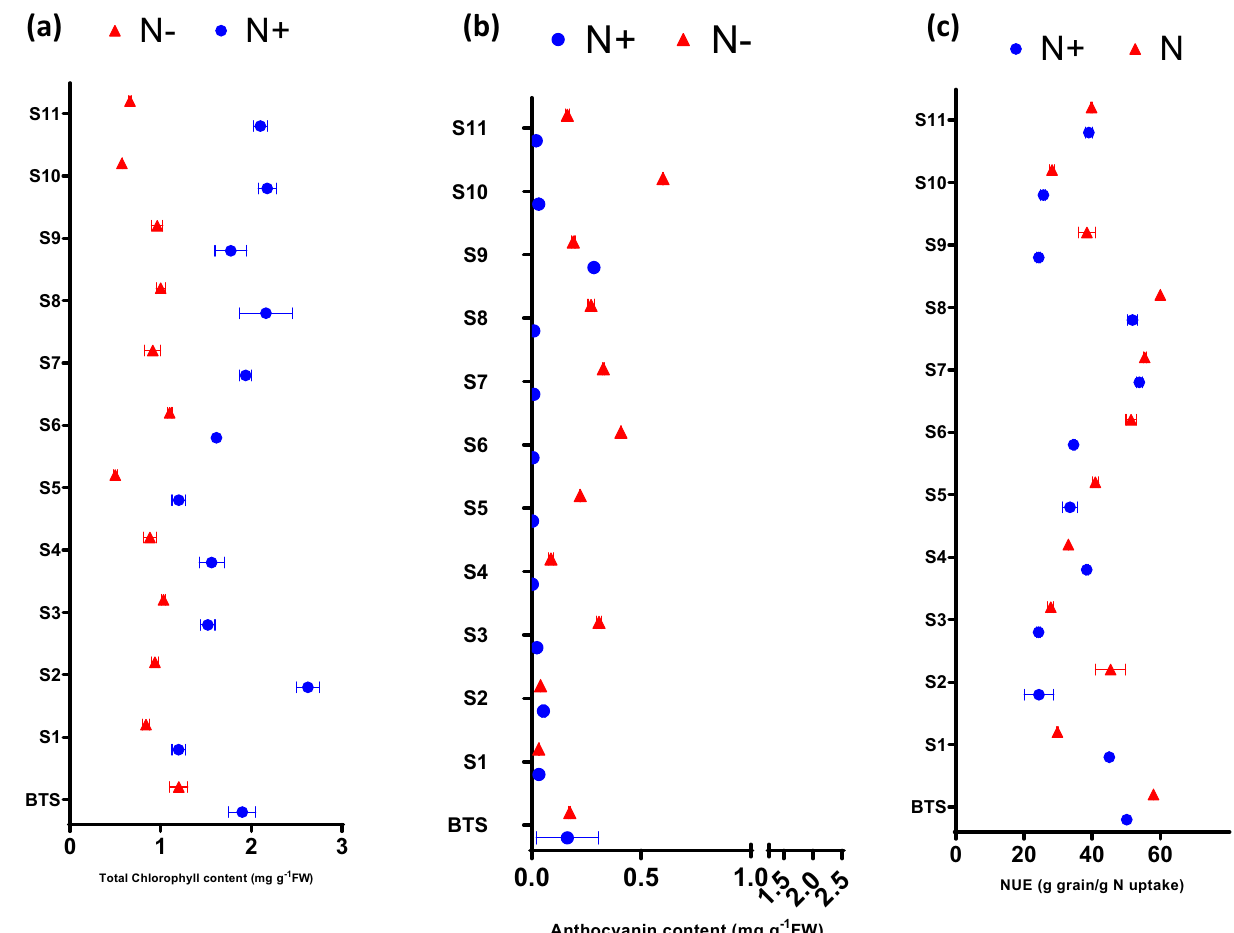
Figure 1. Effect of nitrogen deficient (no applied N: N−) and nitrogen sufficient (120 kg ha −1 applied N: N+) field conditions on ( a ) total chlorophyll content, ( b ) anthocyanin content and ( c ) nitrogen utilization efficiency (NUE) of wheat